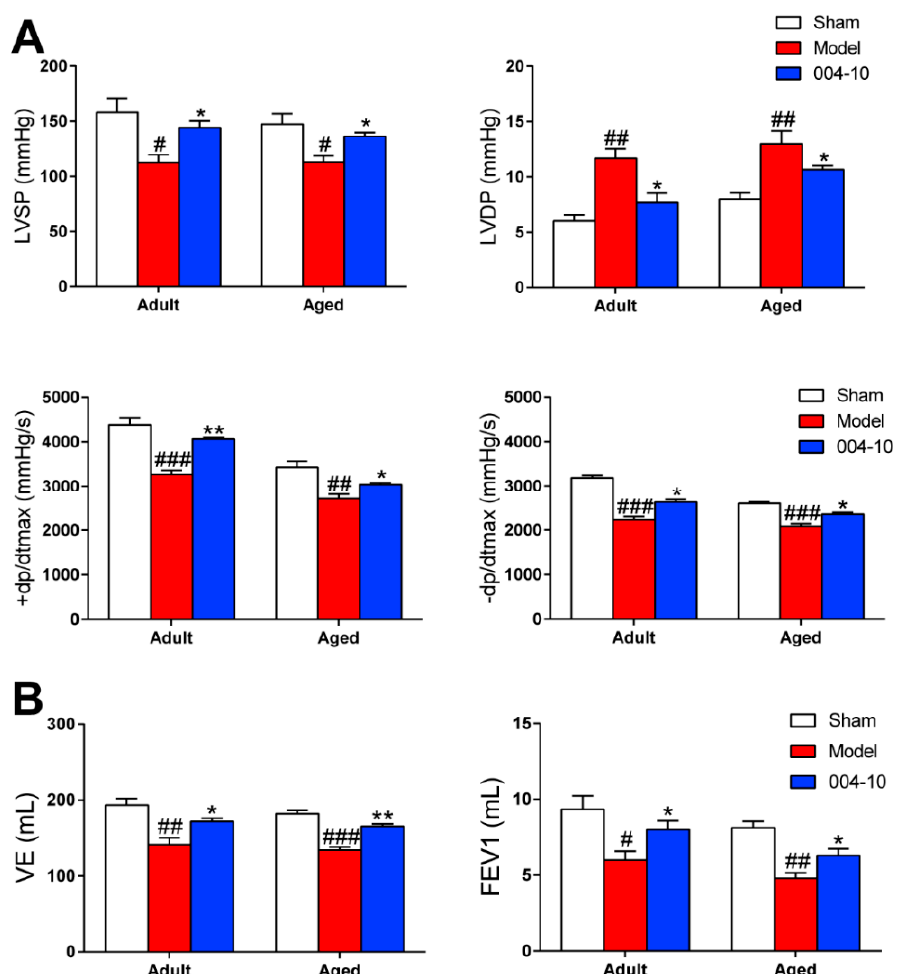
Figure 11. IMM-H004 protects cardiopulmonary function in adult and aged rats. ( A ) Effect of IMM-H004 on adult and aged rats cardiac function including the detection of LVSP, LVDP, +dp/dtmax, and -dp/dtmax. ( B ) Effect of IMM-H004 on adult and aged rats pulmonary function including the detection of VE and FEV1. All the data are shown as the mean ± SD ( n = 6/group). # p < 0.05 vs. sham; ## p < 0.01 vs. sham; ### p < 0.001 vs. sham; * p < 0.05 vs. model; ** p < 0.01 vs. model.